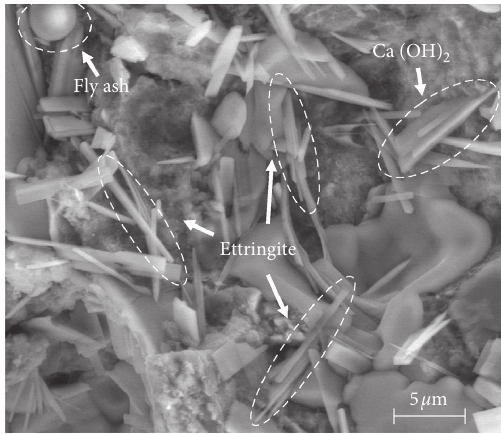
Figure 5: SEM image of saline soil stabilized by 15% stabilizer at an age of 7 days.